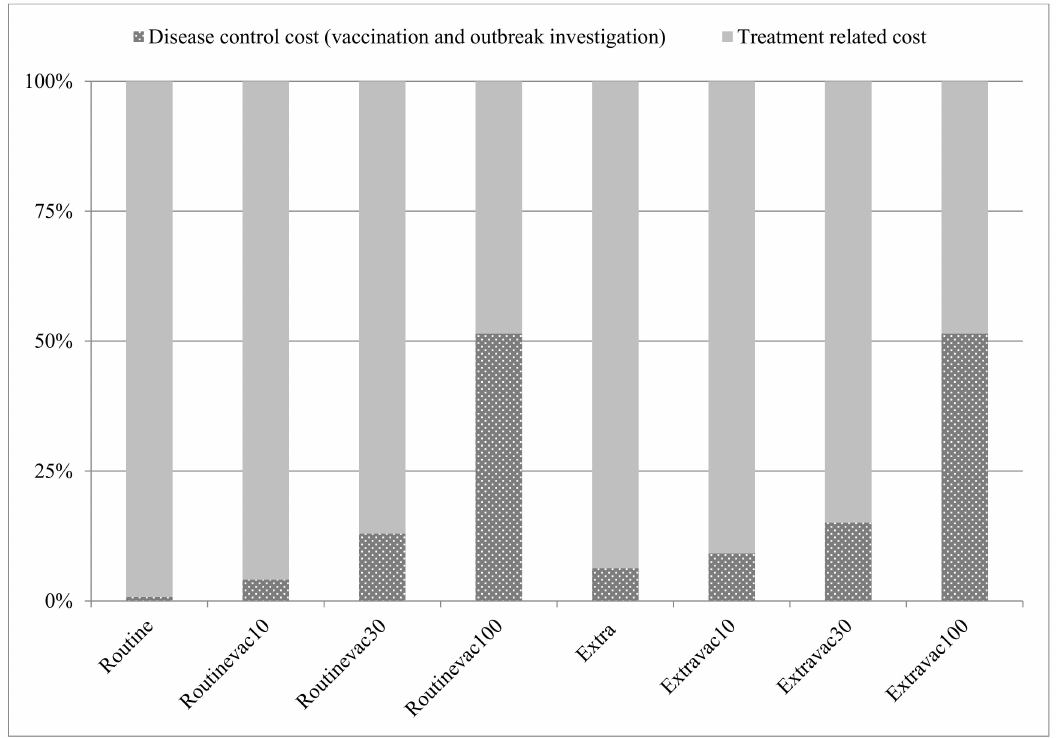
Figure 4. Share of disease control cost and treatment-related cost in each scenario.